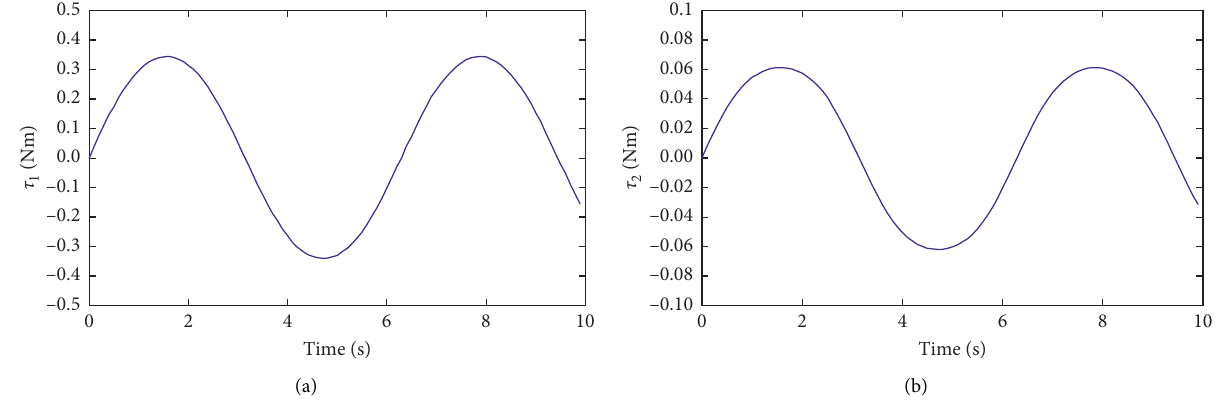
Figure 6: Actuated torque in the joint space as control signal. (a) τ